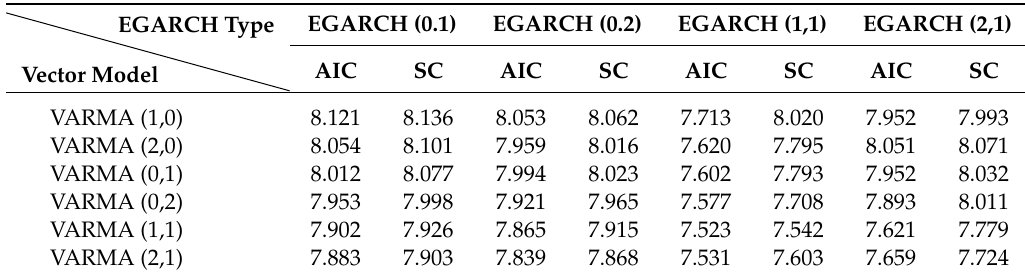
Table 4. Analysis results of the best combination of photochemical pollution factor Vector Autoregressive Moving Average (VARMA) model and Exponential Generalized Autoregressive Conditional Heteroscedasticity (EGARCH)